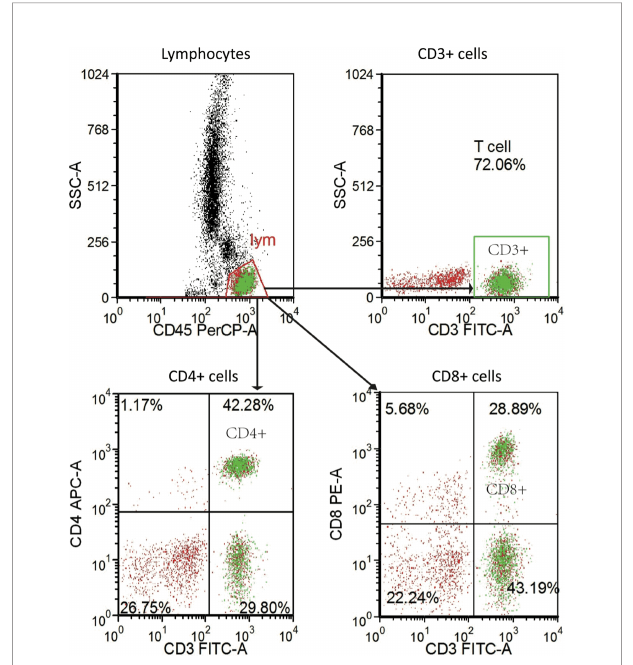
FIGURE 2 | Representative fl ow-cytometry gating strategy for quantifying the numbers of various immune cell subsets in PBMC. PBMC, peripheral blood mononuclear